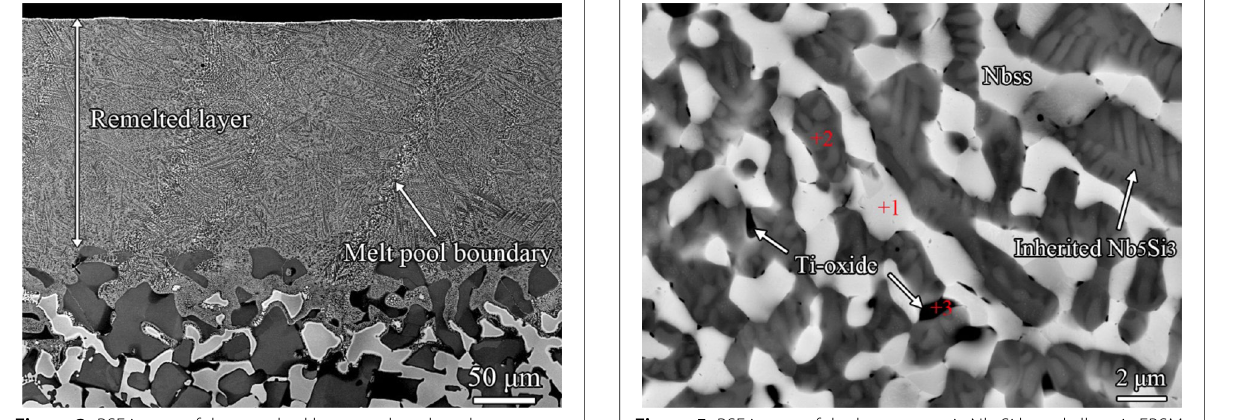
1, 2 and 3 are the + + +